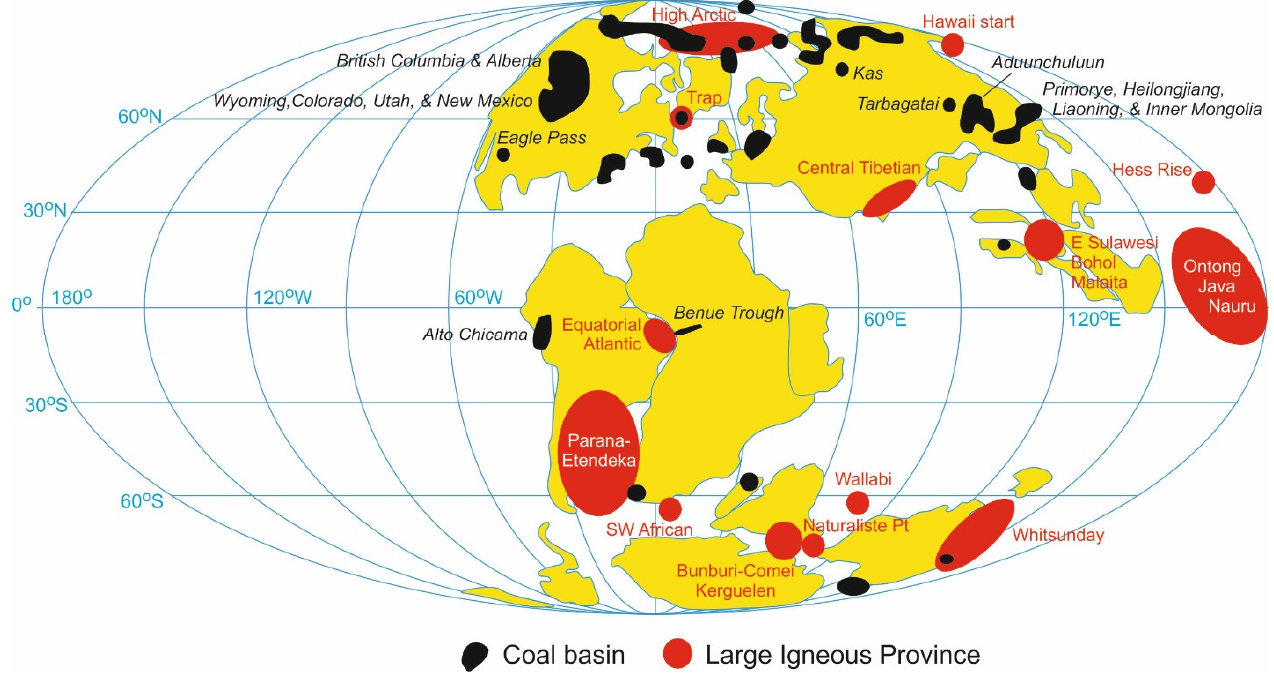
Figure 1. Global distribution of coal basins and LIPs in the Early Cretaceous. Coal basins and LIPs are shown after Ziegler et al. [29] and Ernst et al. [28], respectively. The names in black indicate locations of mineralized coals discussed below. The Benue Trough is shown after Akiniemy et al. [30]. The names in red and white indicate LIPs.